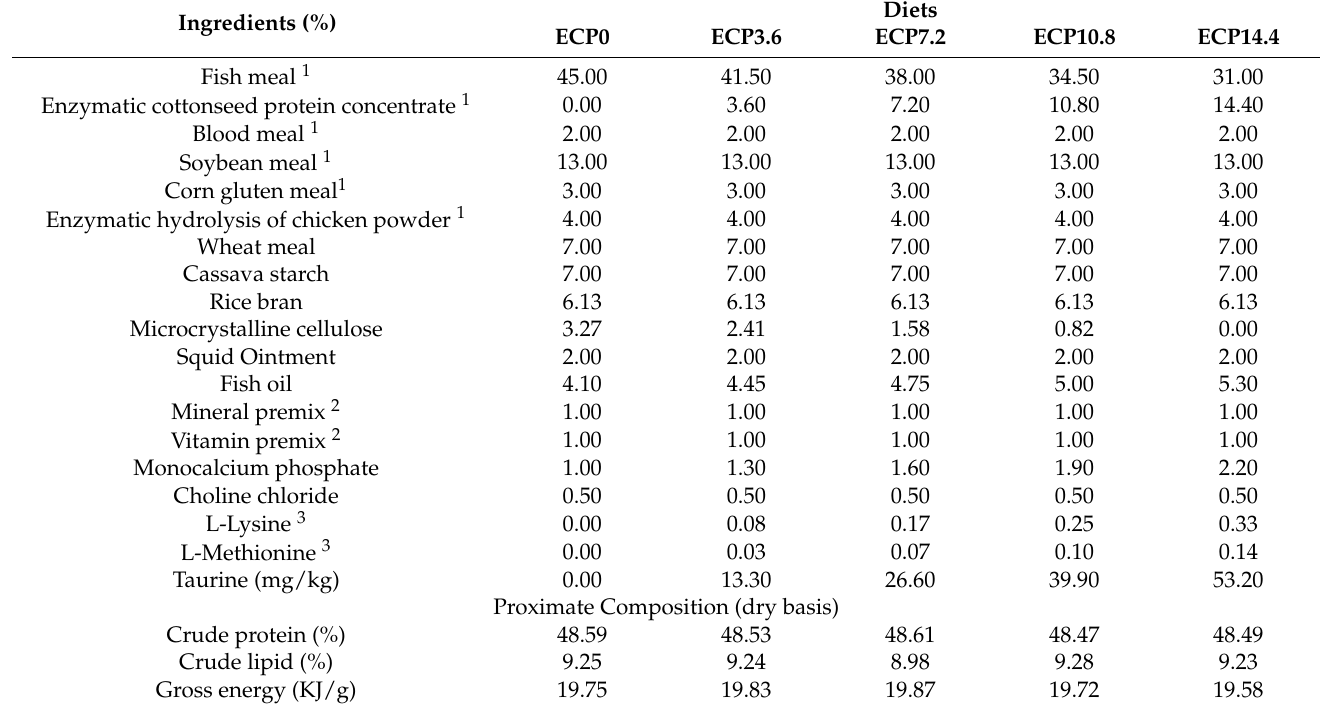
Table 4. Ingredients and nutrient composition of experimental diets (% dry